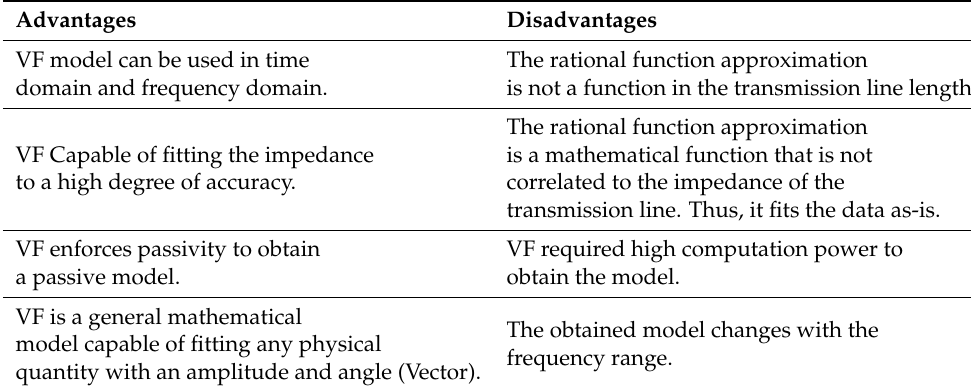
Table 1. Vector fitting method advantages and